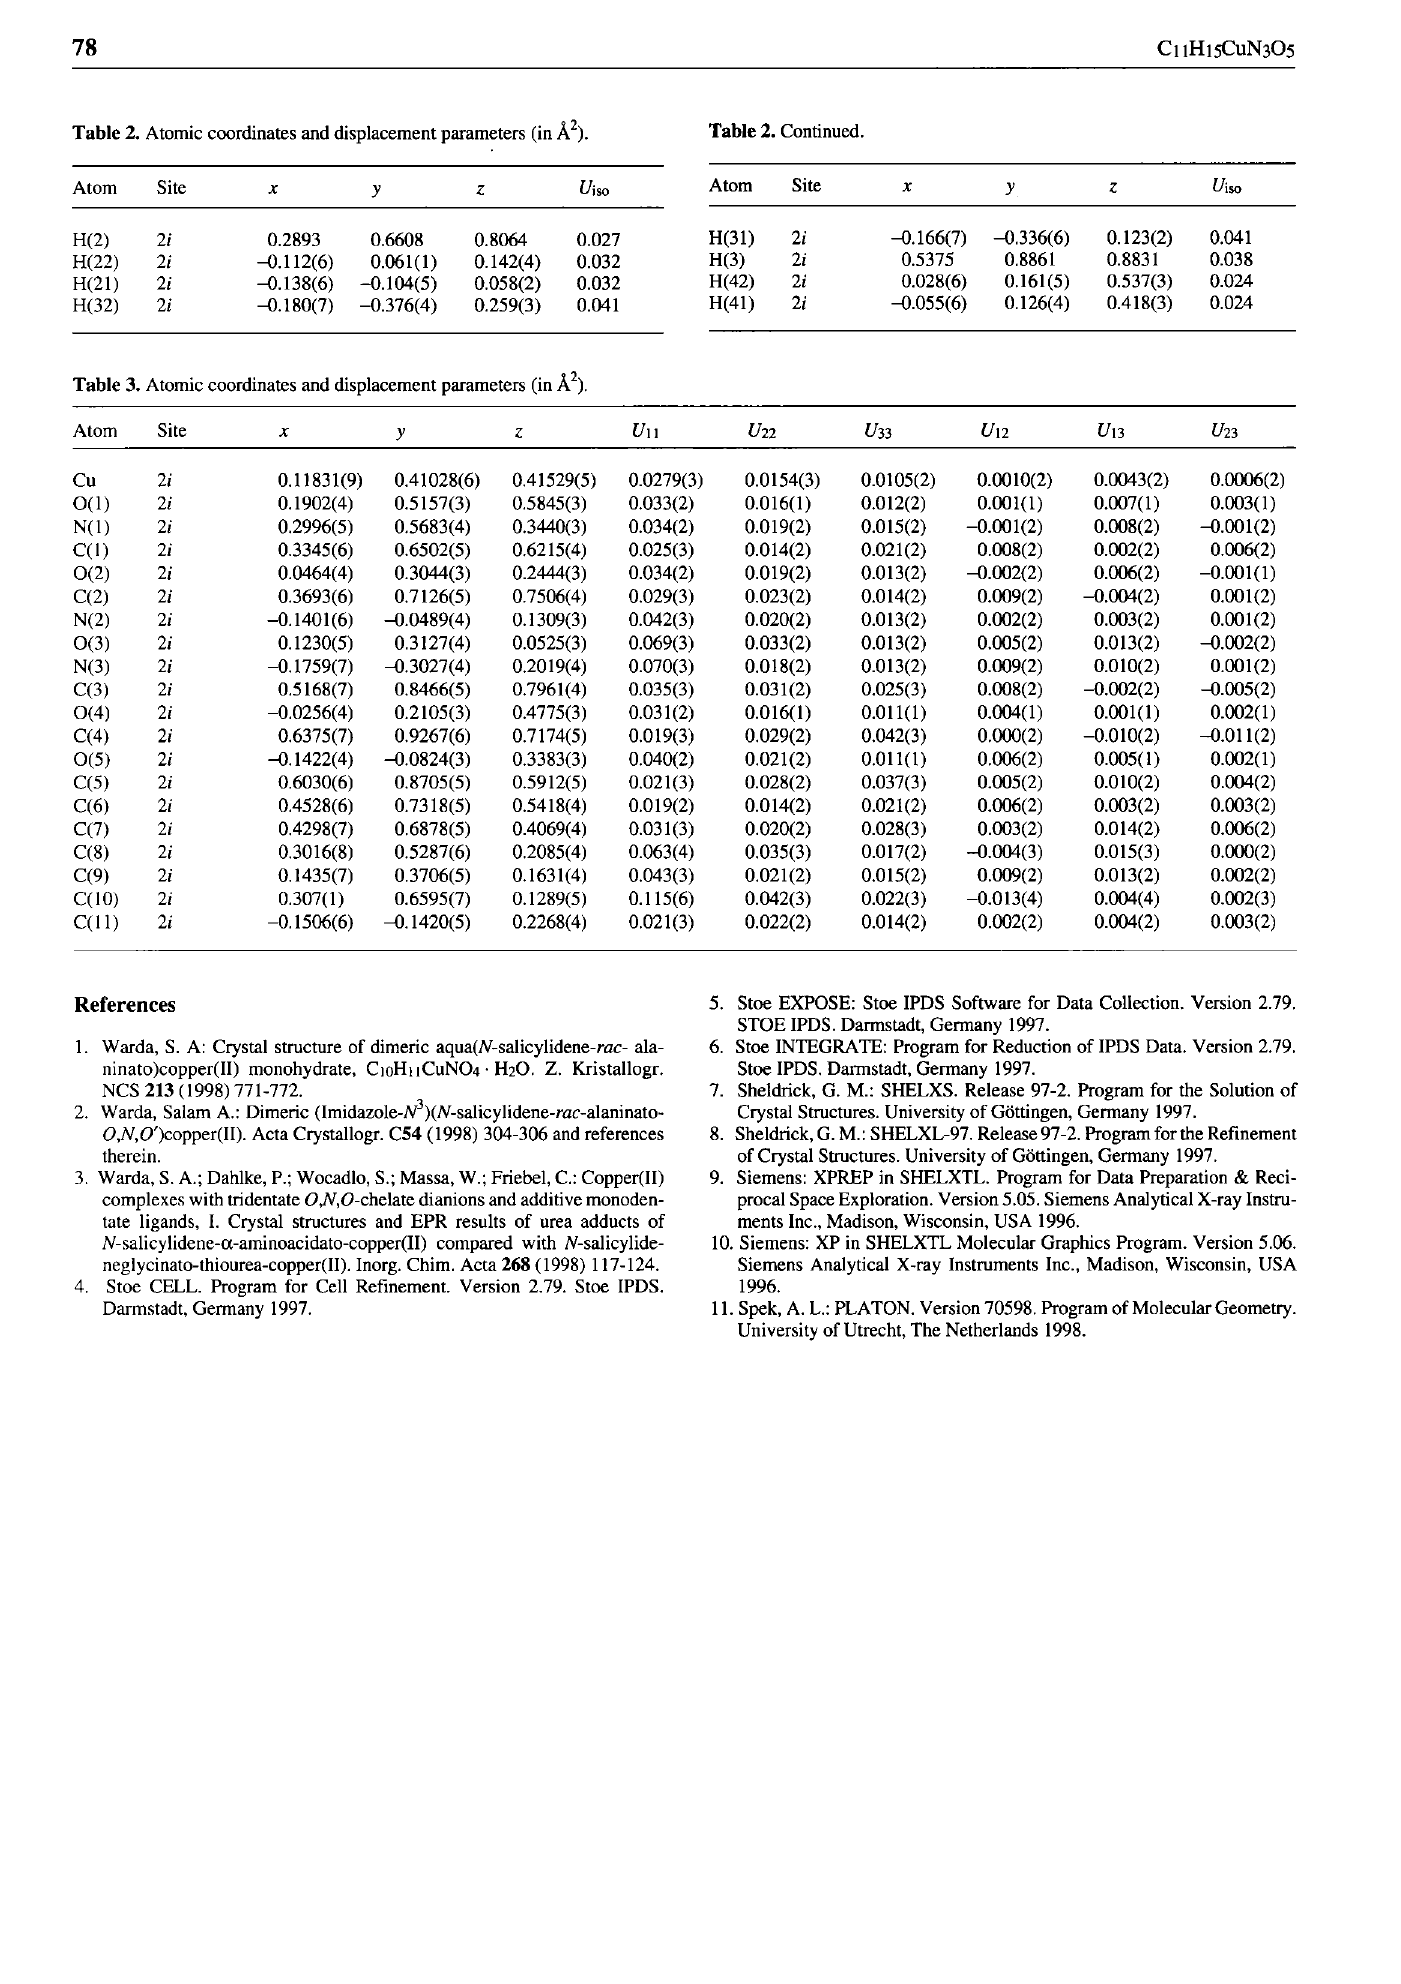
Table 2. Atomic coordinates and displacement parameters (in Â 2 ). Table 2. Continued.